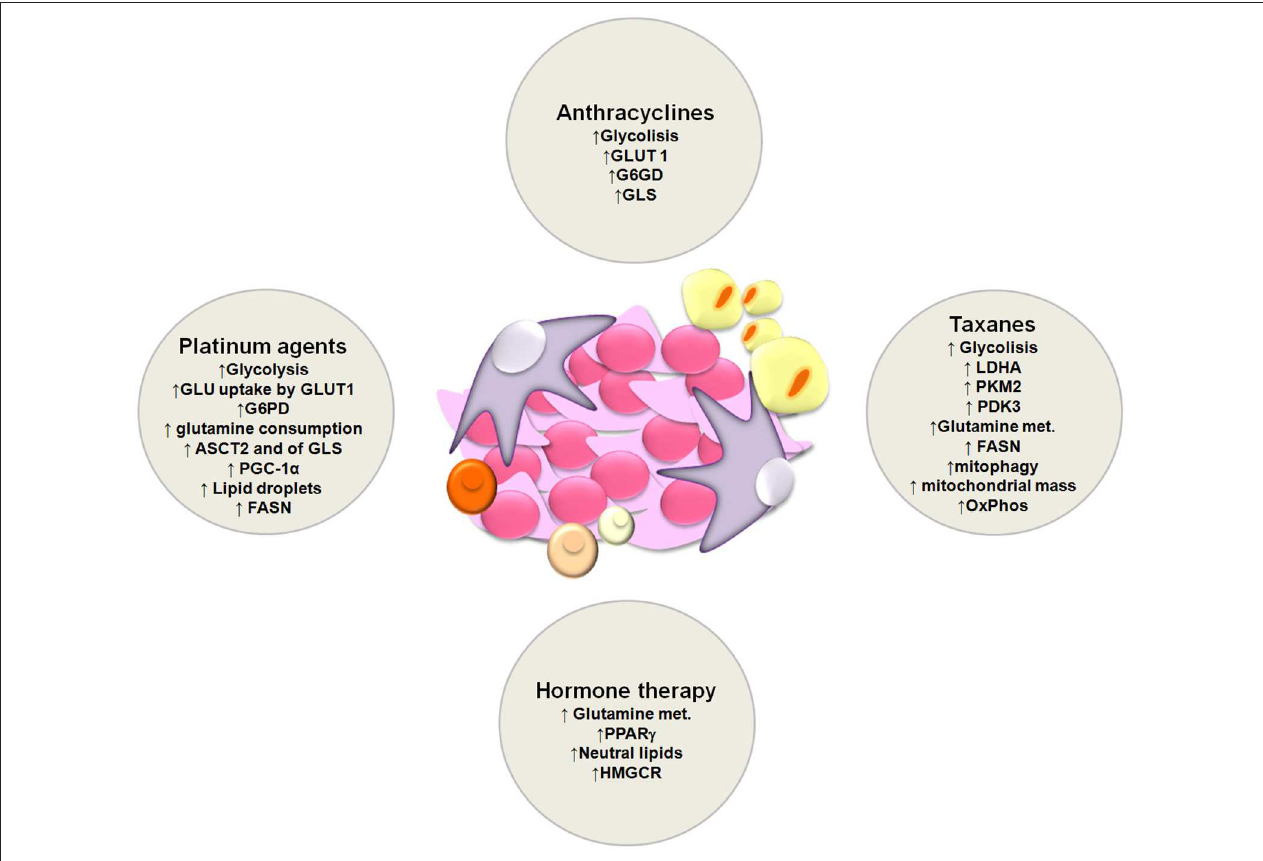
FIGURE 2 | Schematic representation of metabolic alterations involved in the onset of resistance to platinum agents, anthracyclines, taxanes and hormone